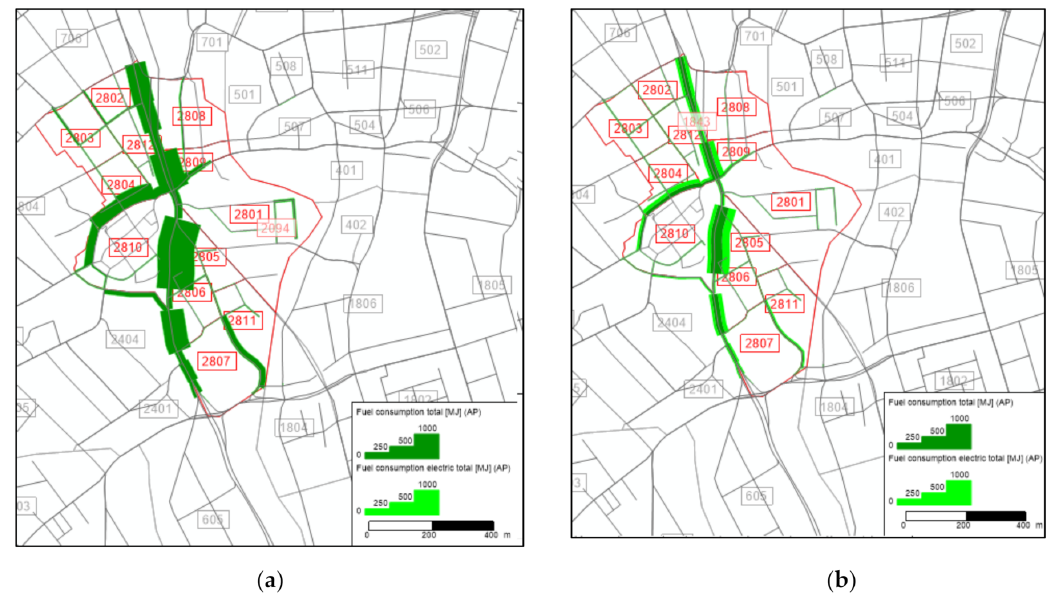
Figure 20. The assessment of fuel consumption total [MJ] and fuel consumption electric total [MJ] (measures from Group 2) for scenario W0 and optimal scenario (W3)—analysis for the central areas of the city: ( a ) measures for scenario W0; ( b ) measures for scenario